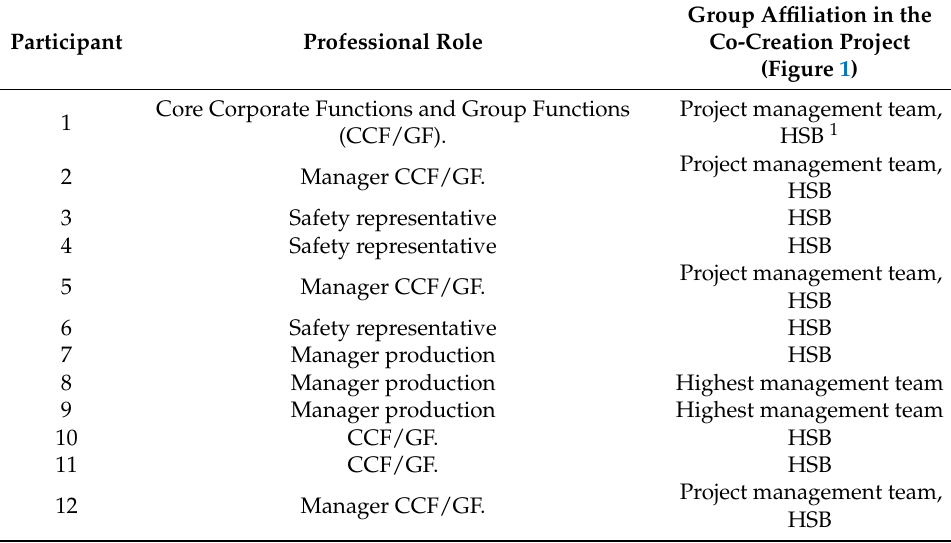
Table 2. Characteristics of the study